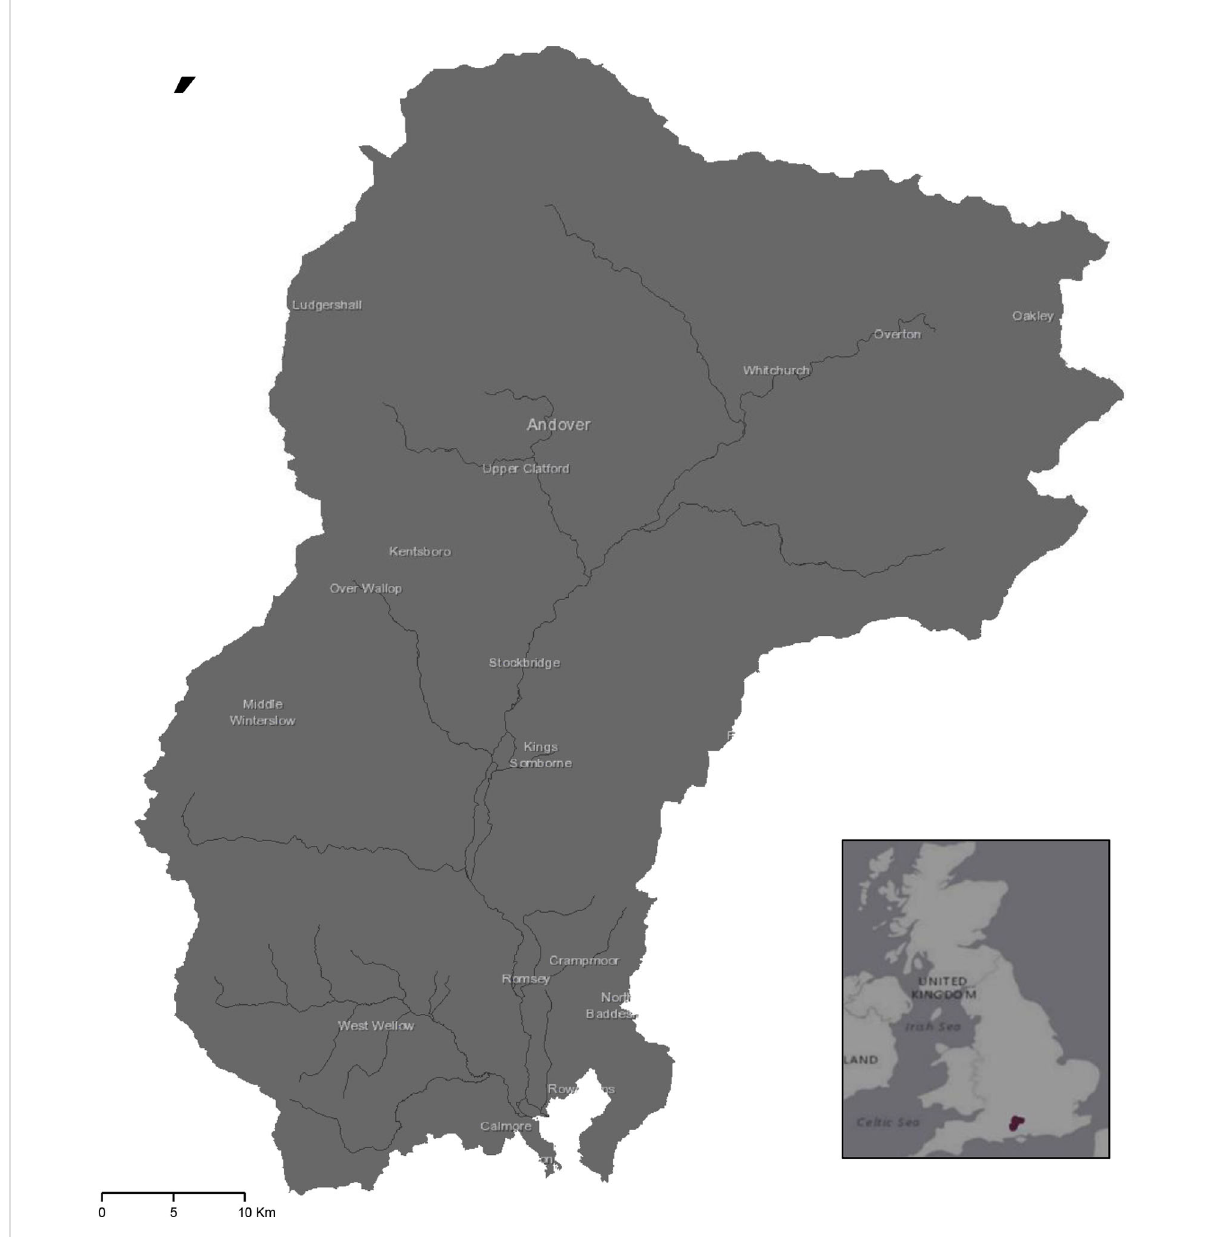
FIGURE 1 The River Test catchment area in Hampshire, UK from which samples were collected from 10 fi elds. Exact locations offarms are concealed for